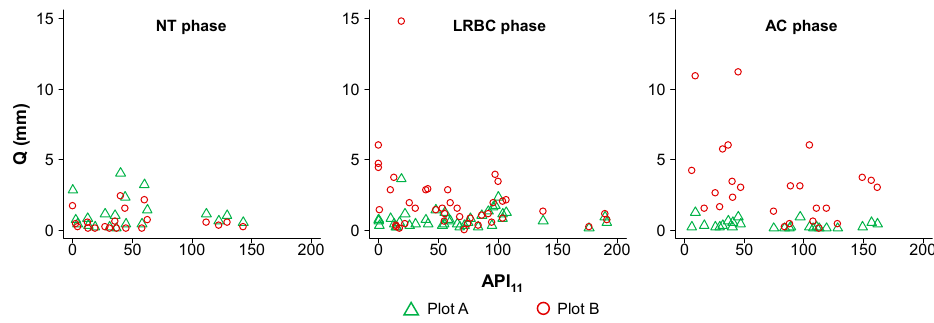
Figure 11. Surface runoff against the 11-day antecedent precipitation index (API 11 ).